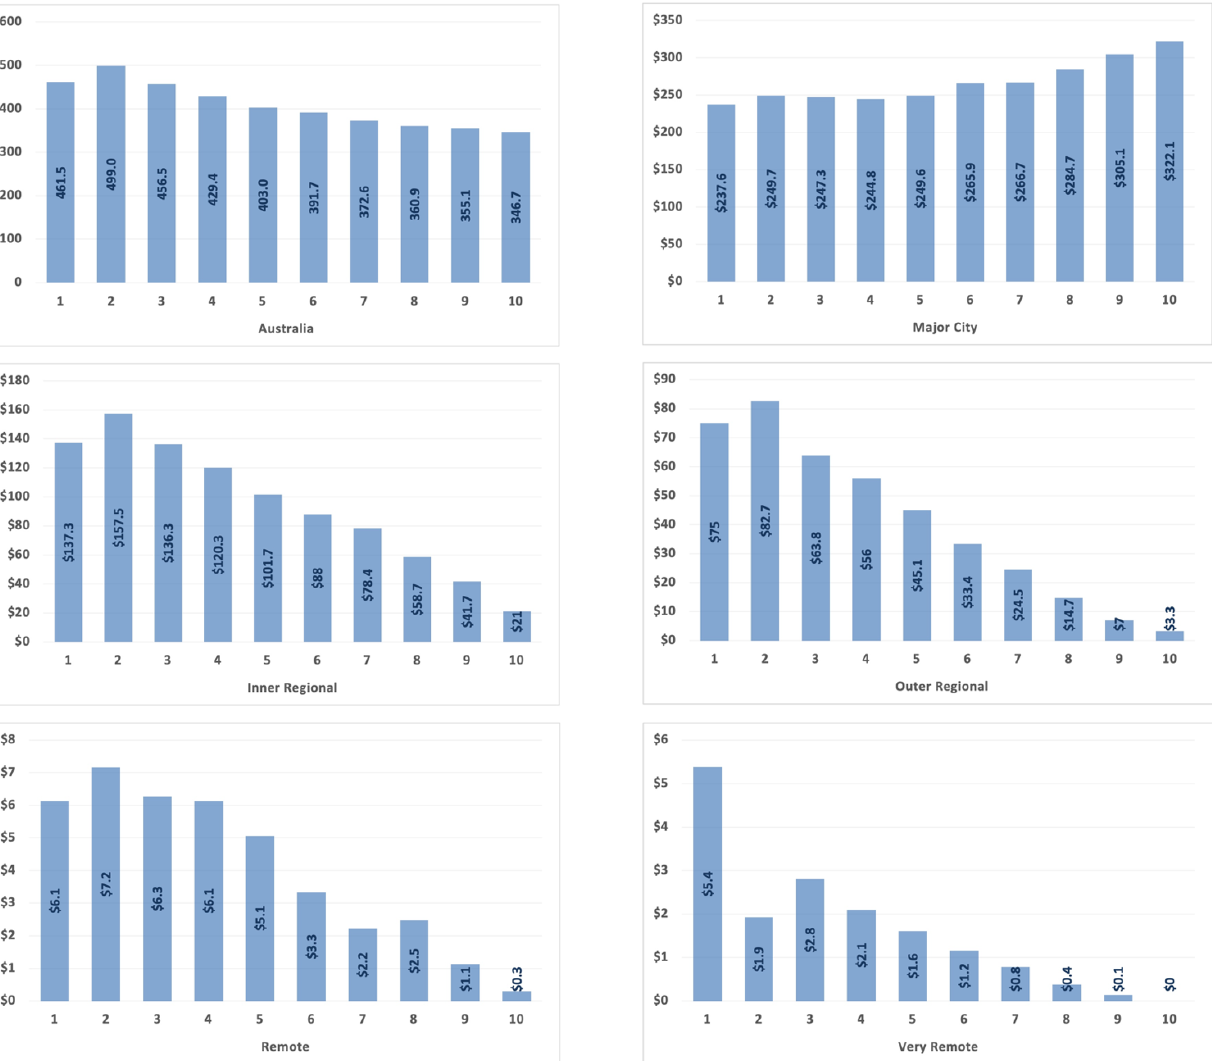
Figure 3. Distribution of the average dental services utilisation cost (million Australian dollars, AUD) of older population by Australia and Remoteness Areas across the IRSD, socioeconomic deprivation deciles (1 – 10).